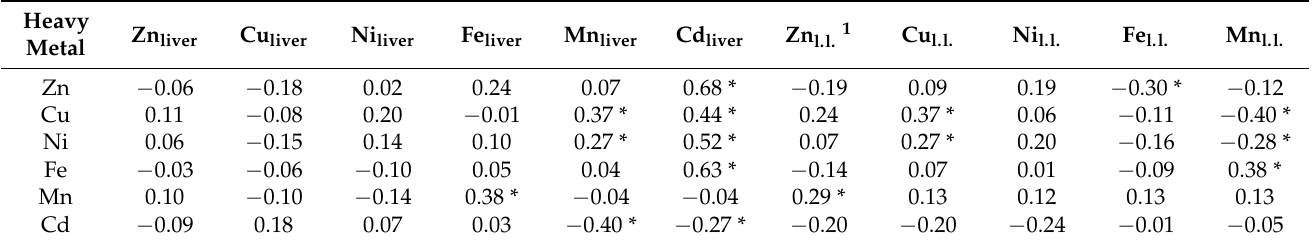
Table 7. The phenotypic correlation coefficients among metals in the fenugreek and liver and rabbit